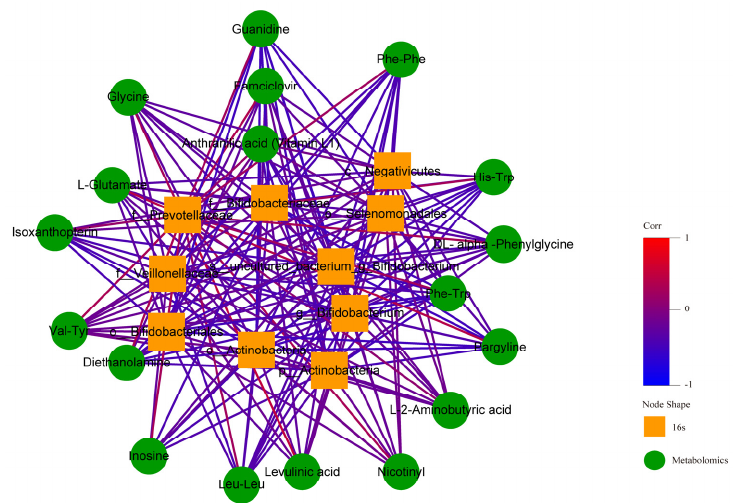
Figure 27. Correlation network diagram in positive ion mode. In the figure, the green circle represents the differential metabolites. The yellow square represents the differential flora. The line represents the correlation coefficient between the differential metabolites and the differential flora. The red line represents the positive correlation, and the blue line represents the negative